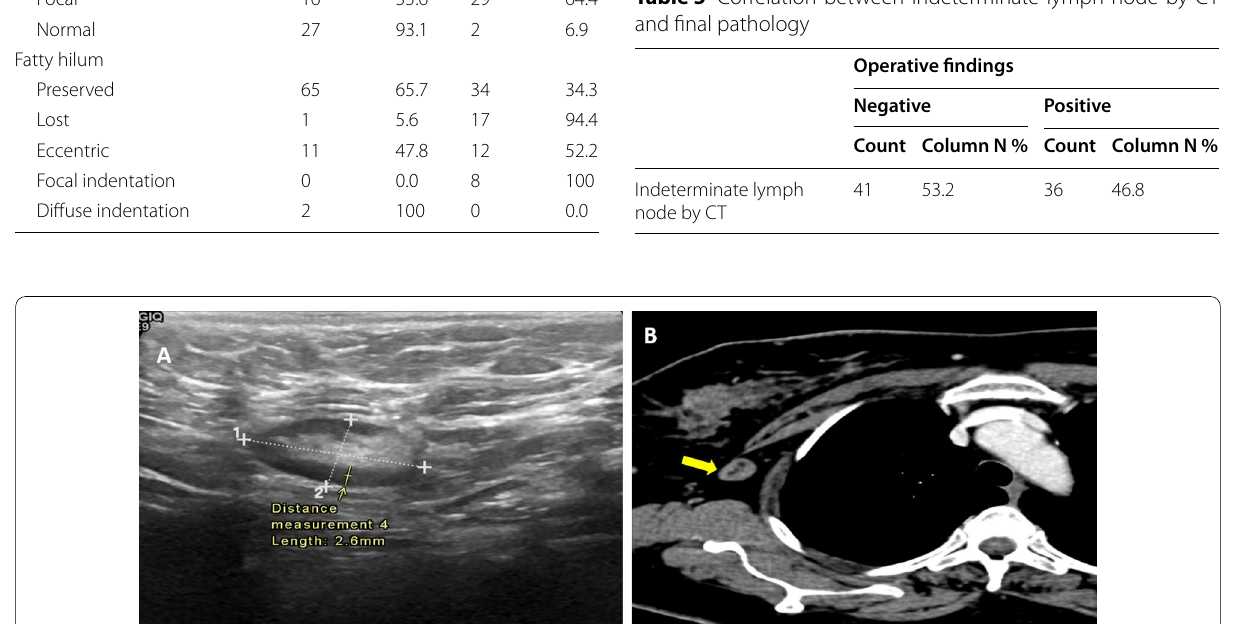
Table 5 Correlation between indeterminate lymph node by